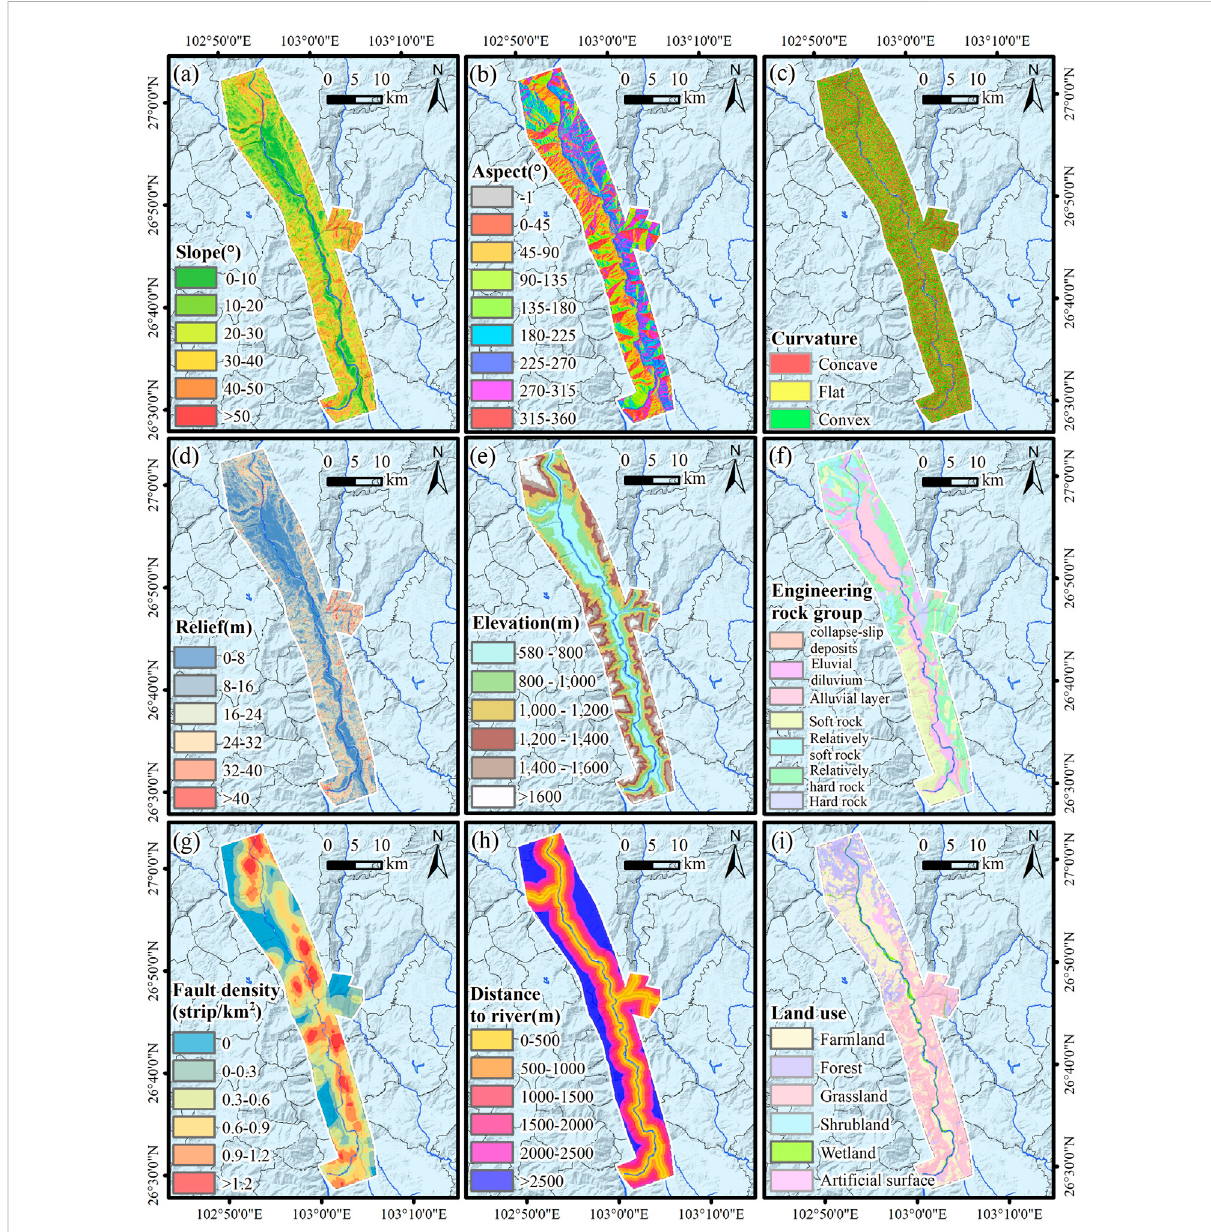
FIGURE 4 Mapping factors of landslide susceptibility in the study area. [ (A) Slope; (B) Aspect; (C) Curvature; (D) Relief; (E) Elevation; (F) Engineering rock group; (G) Fault density; (H) Distance; (I) Land